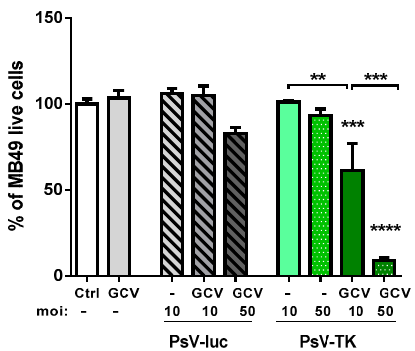
Figure 1. In vitro toxicity of pseudovirions encoding for thymidine kinase (PsV-TK)/Ganciclovir (GCV): Mean ± standard error of the mean (SEM) percentage (%) of viable MB49-cells 6 days after infection with PsV encoding for luciferase (PSV-luc) (stripped bars) or PsV-TK (green bars) at multiplicity of infection (moi) 10 or 50 and in presence or absence of GCV treatment (as indicated) or with GCV treatment alone (plain grey bar) as normalized to untreated cells (Ctrl, white bar). Significant differences with the control group following one-way ANOVA and Tukey post-test are indicated above the bars. Significant differences between specific groups are also shown: ** for p < 0.01, *** for p < 0.001 and **** for p < 0.0001.